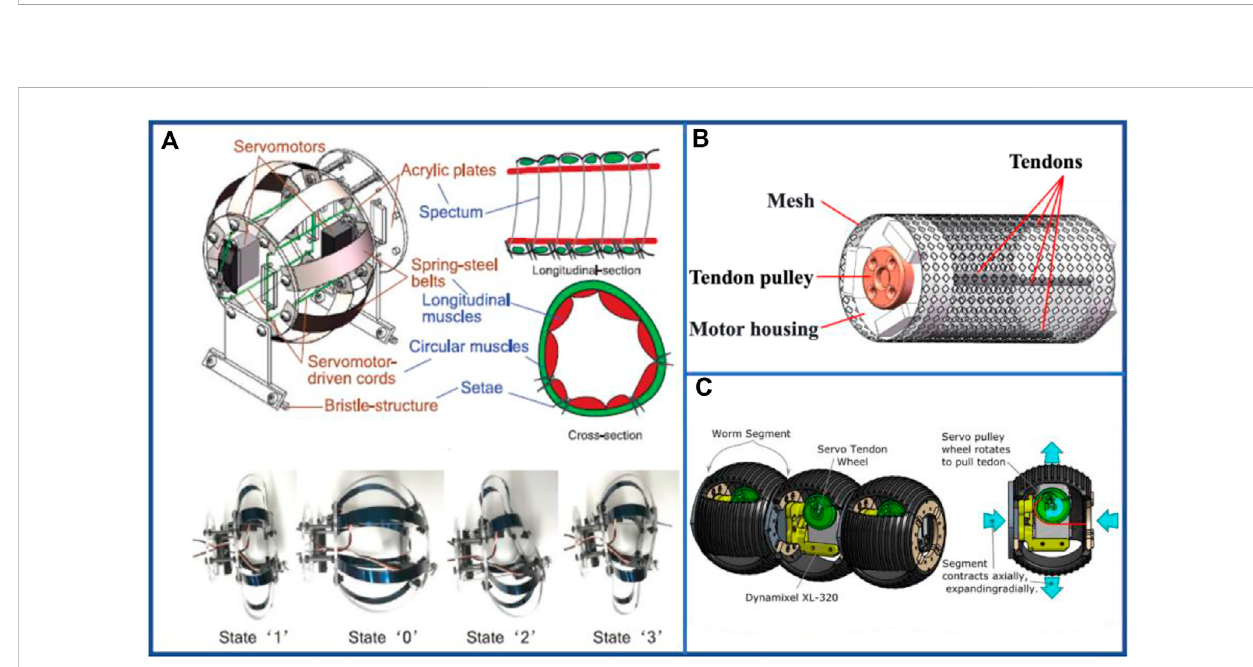
FIGURE 12 Examplesofwire-drivenmulti-segmentearthworm-inspiredsoftrobots. (A) Designandprototypeofearthworm-likelocomotionrobot(Zhanetal., 2019). Reproduced from Ref. (Zhan et al., 2019). with permission. (B) 3D model of segment of typical wire-driven robot. (C) Dynamixel driven robot constructed to test each waveform and compare performance and identify optimal gearbox parameters (Winstone et al., 2016). Reproduced from Ref. (Winstone et al., 2016). with